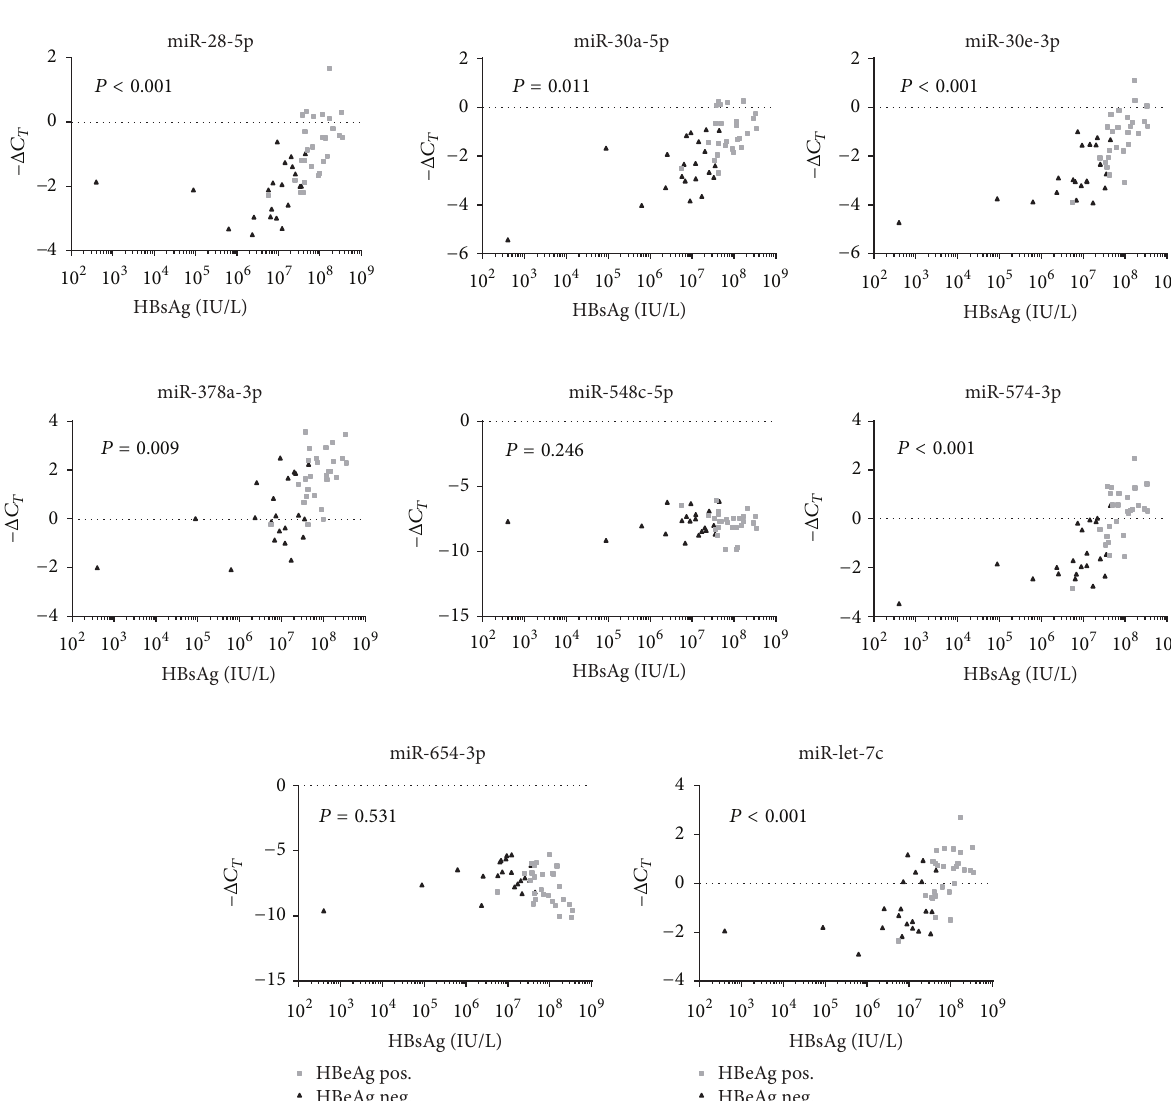
interventions has shown great promise [11], and the first artificial microRNA antagonist is already in clinical trial